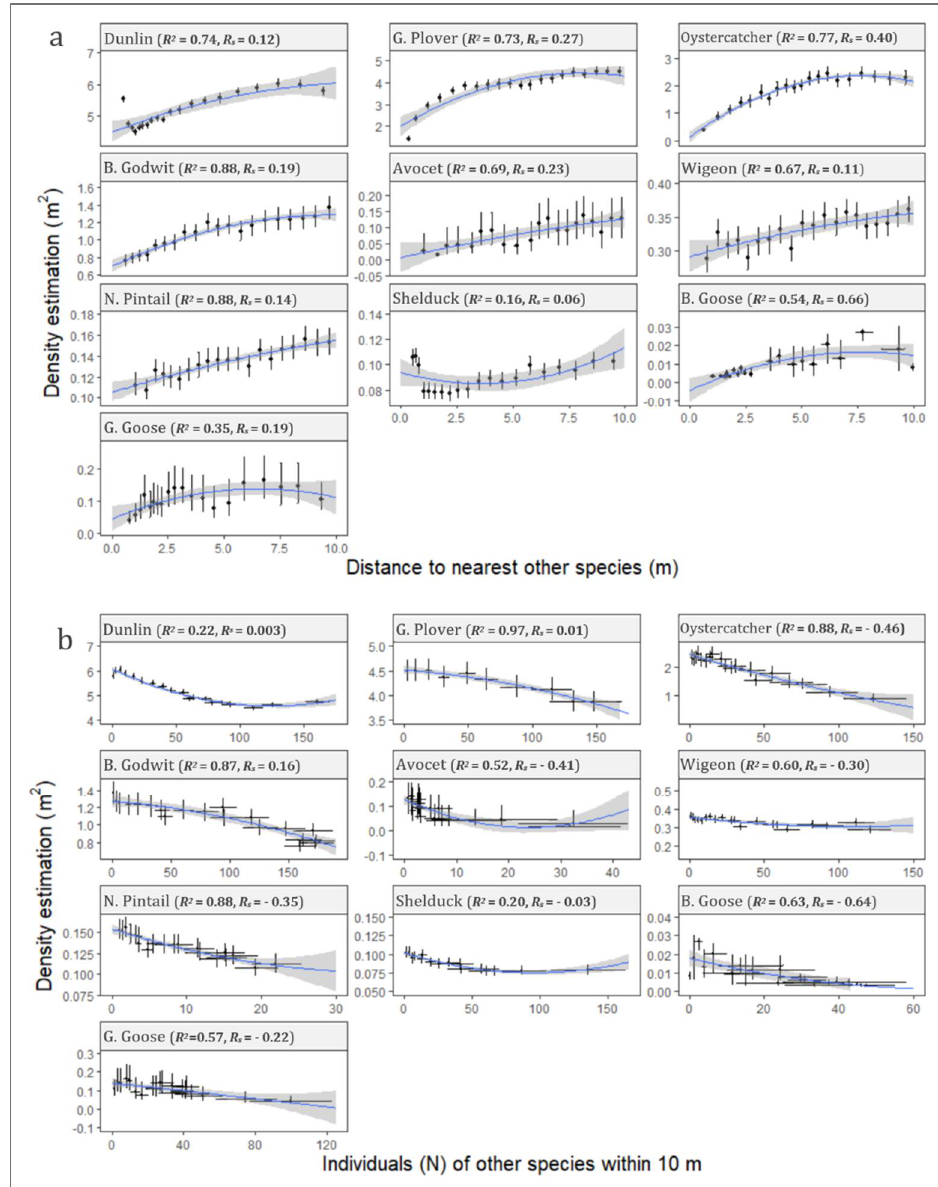
Figure 7. Graphical illustration of inter-species interactions expressed as altered densities. Two possible indicators for inter-species interactions were investigated: influence of nearest inter-species distance ( a ), and influence from number of individuals of other species within a 10 m circular zone ( b ). Data are grouped in percentile intervals with means and adhering 95% bootstrapped confidence intervals (CI) calculated, based on the density estimate and distance ( a ) and number ( b ). Quadratic polynomial regressions of the density estimations (denoted by blue lines) were derived for each species for both interaction indicators ( a , b ) and standard errors (SEs) calculated (grey-shaded areas). R-squared ( R 2 ) and Spearman’s rank correlation coefficient ( R s ) values are shown for each